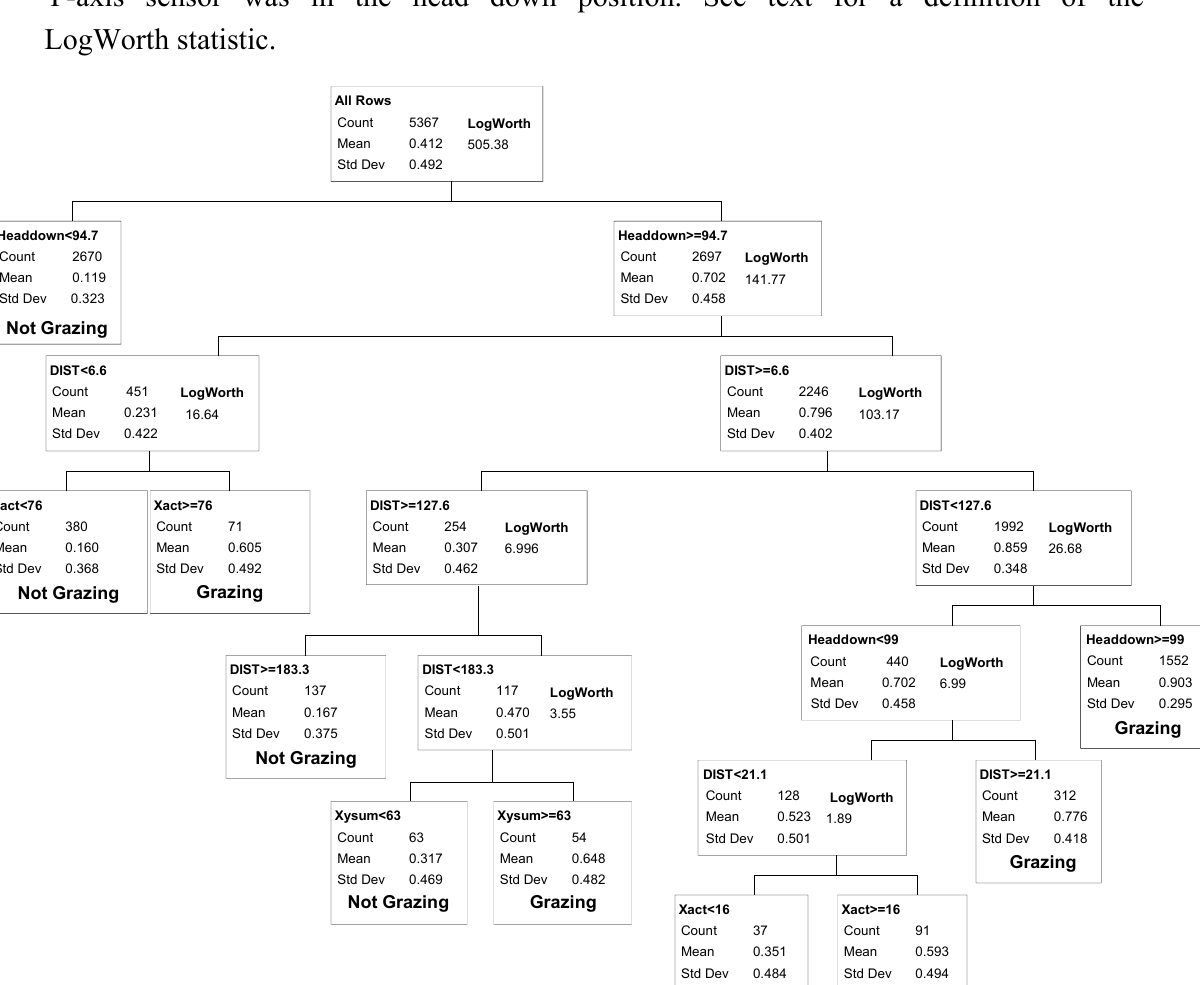
Figure 2. Selected binary classification tree differentiating cattle grazing vs. non-grazing activities based upon movement distances and activity sensor data collected at 5-minute intervals with Lotek 3300LR GPS collars on yearling steers in eastern